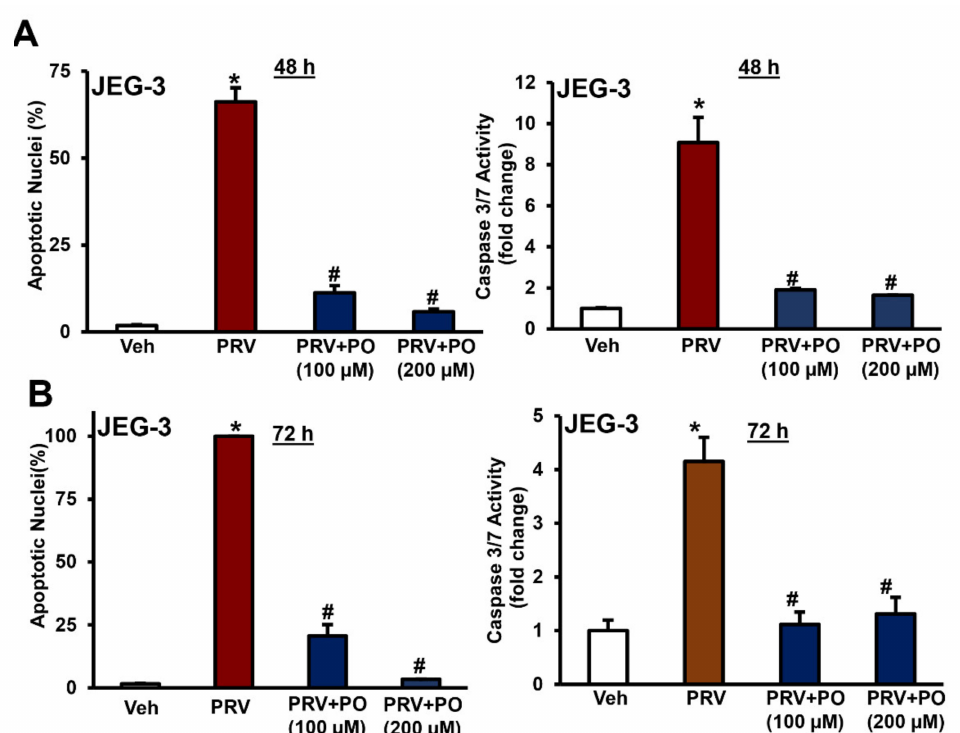
Figure 1. Palmitoleate treatment after Zika virus (ZIKV) PRVABC59 strain (PRV) infection inhibits apoptosis in JEG-3 cells. ( A ) Structural and biochemical characterization of apoptosis in JEG-3 infected with the 1.0 MOI (multiplicity of infection) ZIKV PRV strain, 48–72 h showed an increase in percent apoptotic nuclei compared to uninfected vehicle cells. Infected cells treated with 100 or 200 µ M of palmitoleate, 48–72 hpi (hours post infection) showed a decrease in the percent apoptotic nuclei when compared to ZIKV-infected cells alone (left panels). ( B ) There was a significant activation of caspase 3/7 in ZIKV-infected cells, but caspase 3/7 activation was significantly blocked when the infected cells were treated with 100 or 200 µ M of palmitoleate both at 48 and 72 hpi (right panels). Data represent mean ± SEM, n = 3. * p < 0.05 compared to uninfected vehicles cells, # p < 0.05 compared to ZIKV-infected